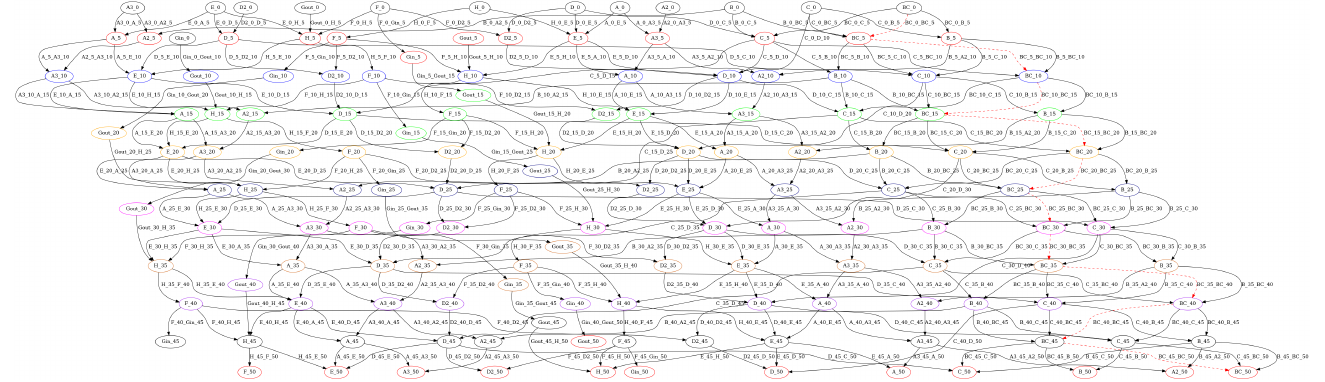
Figure 7. Constructed time–space